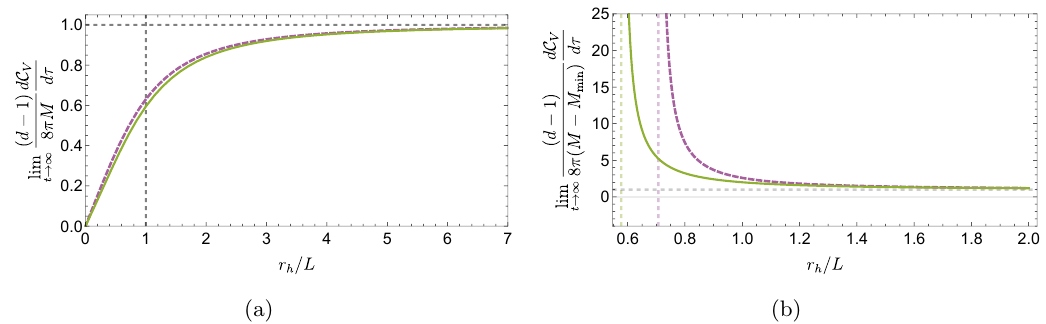
Figure 6 . (a) Late time rate of change in complexity d (cid:0) 1 lim (cid:28) !1 d C V =d(cid:28) as a function of r h =L for 8 (cid:25)M spherical black holes ( k = 1) in d = 3 (green) and d = 4 (dashed purple) dimensions. The vertical dashed line at r h =L = 1 indicates the Hawking-Page phase transition below which the dominant saddle point in the bulk partition function is vacuum AdS rather than a (small) spherical black hole. (b) Plots of ( d (cid:0) 1) lim (cid:28) !1 d C V =d(cid:28) as a function of r h =L for hyperbolic black holes ( k = (cid:0) 1) 8 (cid:25) ( M (cid:0) M min ) in d = 3 (green) and d = 4 (dashed purple) dimensions. The vertical lines indicate the minimal values of r h =L corresponding to extremal small hyperbolic black holes. The gray dashed horizontal line indicates 1, which is approached in the large black hole limit ( r h (cid:29) L ).